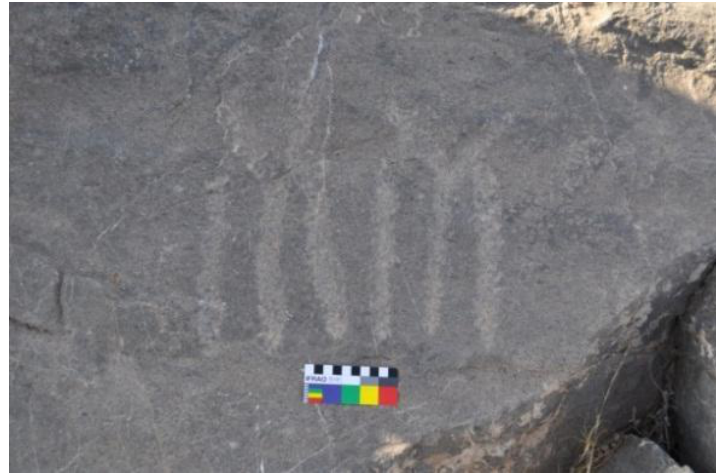
Figure 5. Ghārā-Tepe I, panel 3, geometric markings.